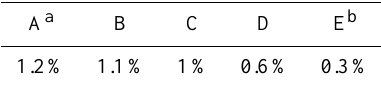
Table A4. Applied annual efficiency change rates. A a B C D E b 1.2% 1.1% 1% 0.6%